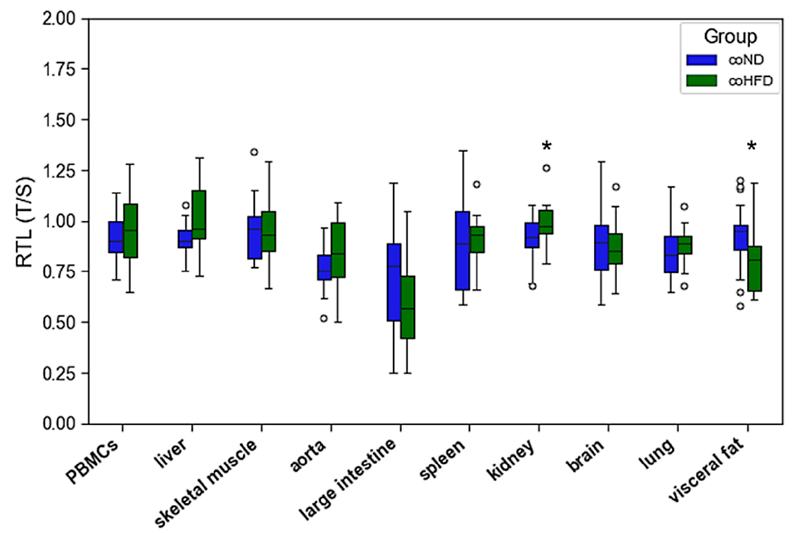
Figure 2. Distribution of RTL in PBMCs and nine solid organs isolated from lean (coND) and obese rats (coHFD). Outliers are shown as white circles above the box plots. RTL is expressed as ratio of average telomere length to the reference gene GAPDH. The two-tailed Student’s t -test or the Mann–Whitney U-test were used for group comparison of independent samples. * p < 0.05 vs. coND. TERT mRNA expression varied substantially between tissues with highest expression levels in liver and kidney. The consumption of HFD did not result in a systematic difference of TERT mRNA expression across different organs (Figure 3). Spleen, large intestine, and kidney showed higher TERT mRNA expression levels in coHFD than in coND animals, whereas in visceral fat a lower TERT mRNA expression was observed.